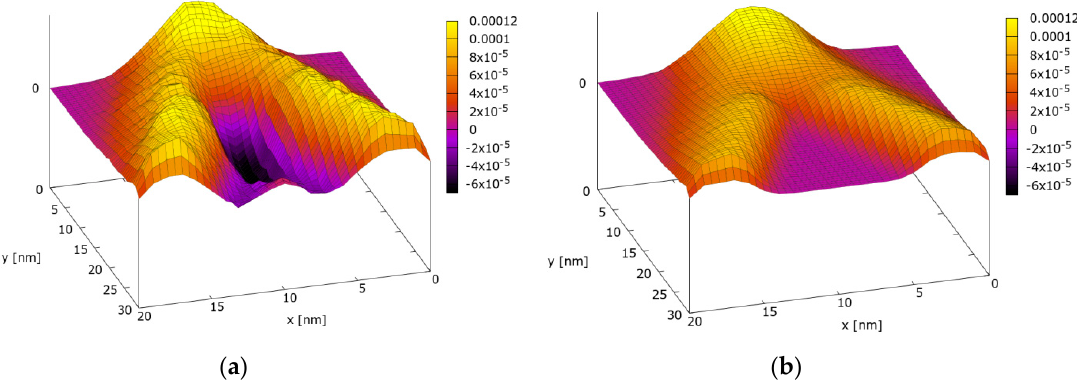
Figure 6. Comparison between quantum and classical sum of the phase-space distributions in the points ( k x1, k y1 ) = ( − 0.26 nm − 1 , 0.89 nm − 1 ) and ( k x2, k y2 ) = (0.26 nm − 1 , 0.89 nm − 1 ): ( a ) quantum Wigner distribution, ( b ) classical Boltzmann distribution.